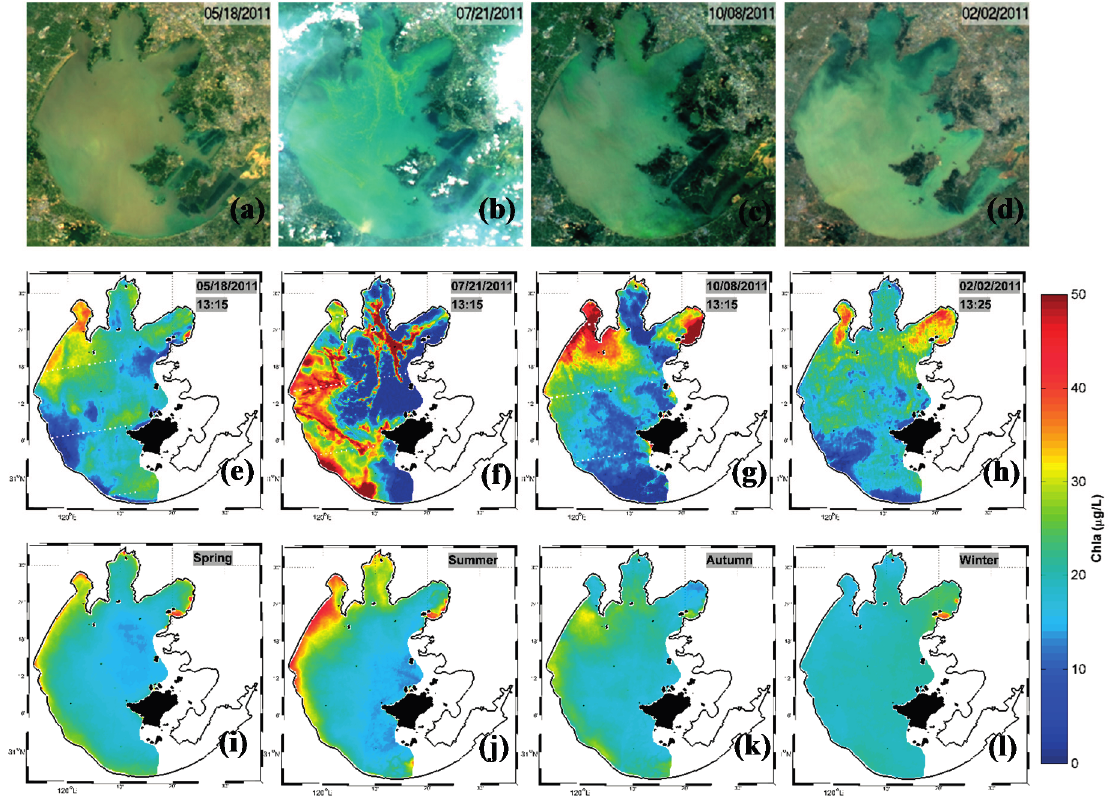
Figure 6. Examples of MODIS RGB and Chla in different seasons. The top panels ( a–d ) show MODIS RGB images selected in the four seasons, the middle panels ( e–h ) show the retrieved Chla corresponding to the RGB images, and the bottom panels ( i–l ) show the seasonal mean Chla between 2000 and